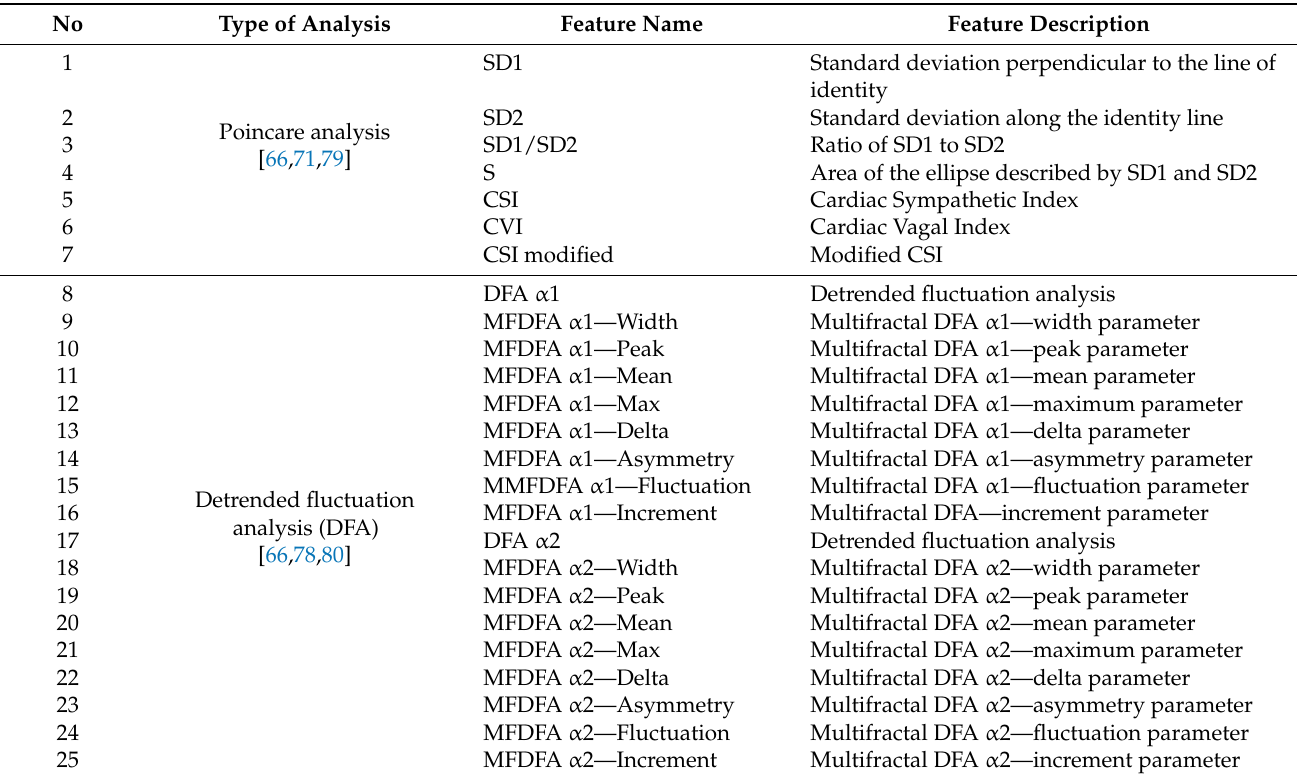
Table 5. List of extracted features of NN interval data in nonlinear